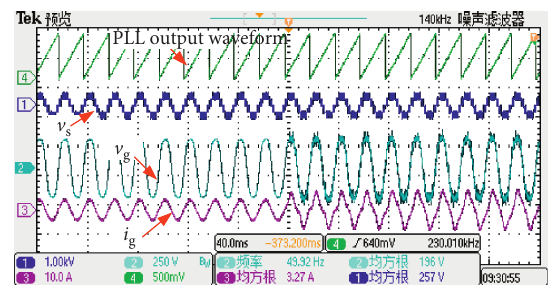
Figure 19: Off-grid operation to grid-connected operation